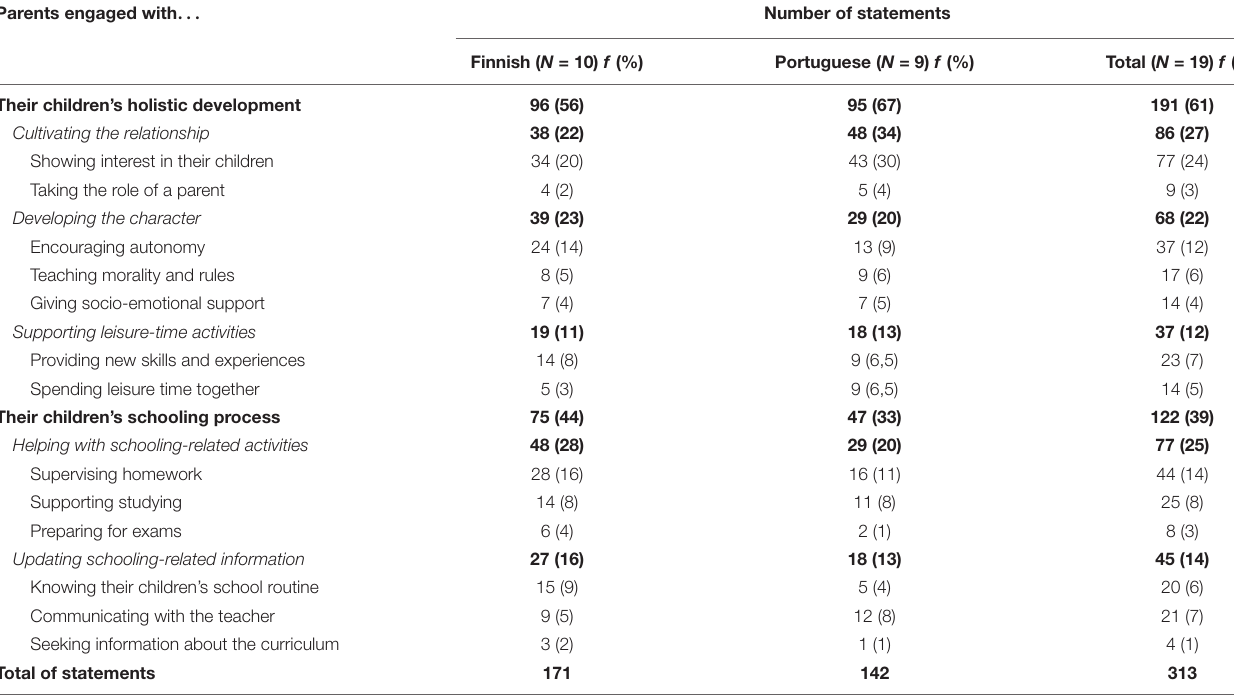
TABLE 2 | Frequencies of the subcategories and main categories of parental engagement at home. Parents engaged with ...